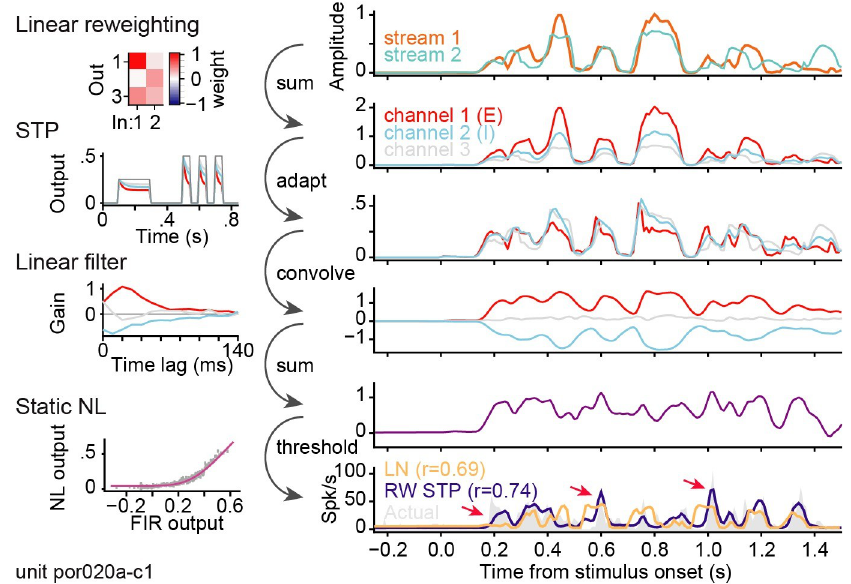
Fig 3. Transformation applied to incoming vocalization-modulated noise for a local short-term plasticity (STP) model estimated for one A1 neuron. Spectral reweighting emphasizes input stream 1 in channel 1 (red), stream 2 in channel 2 (blue), and both streams in channel 3 (gray). All three reweighted channels undergo independent STP. For this neuron, STP is stronger for channel 1 than for the other channels. The linear filter produces excitation for channel 1 and inhibition for channel 2. After the final static nonlinearity (NL), the predicted PSTH (bottom panel, purple) shows a good match to the actual PSTH (gray shading), while the prediction of the LN model does not predict the response dynamics as accurately (orange). Arrows indicate transient PSTH features captured better by the STP